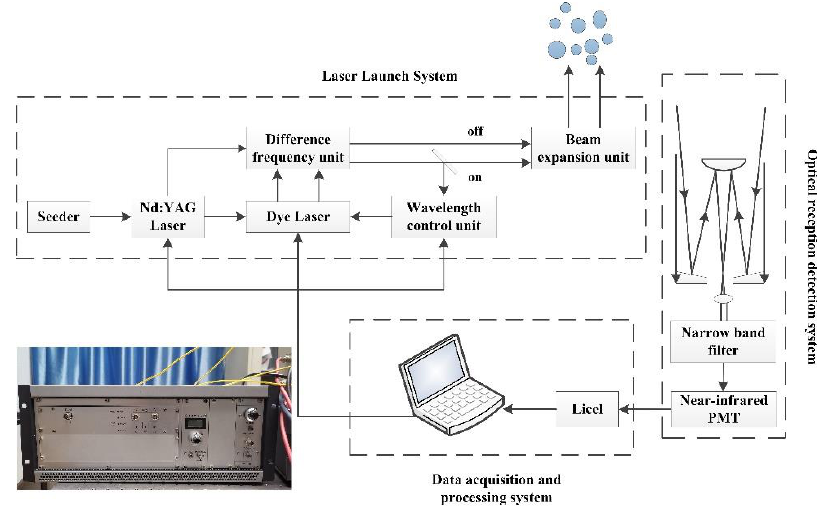
Figure 1. Configurations of ground-based CO 2 -DIAL system.